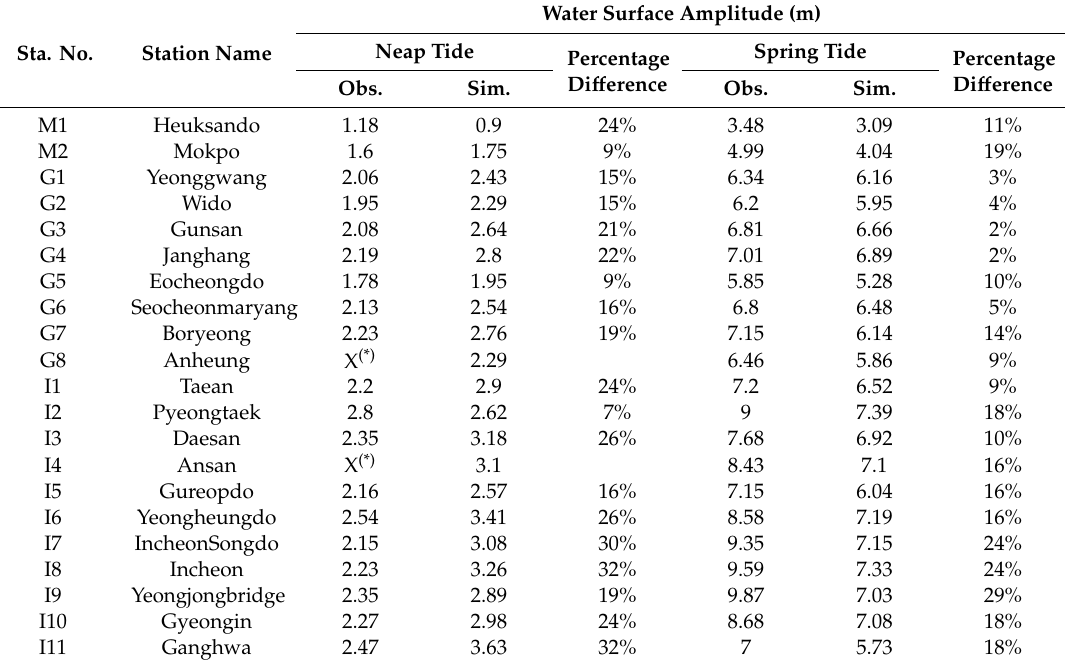
Table A14. A comparison of water surface level at the gauge stations.